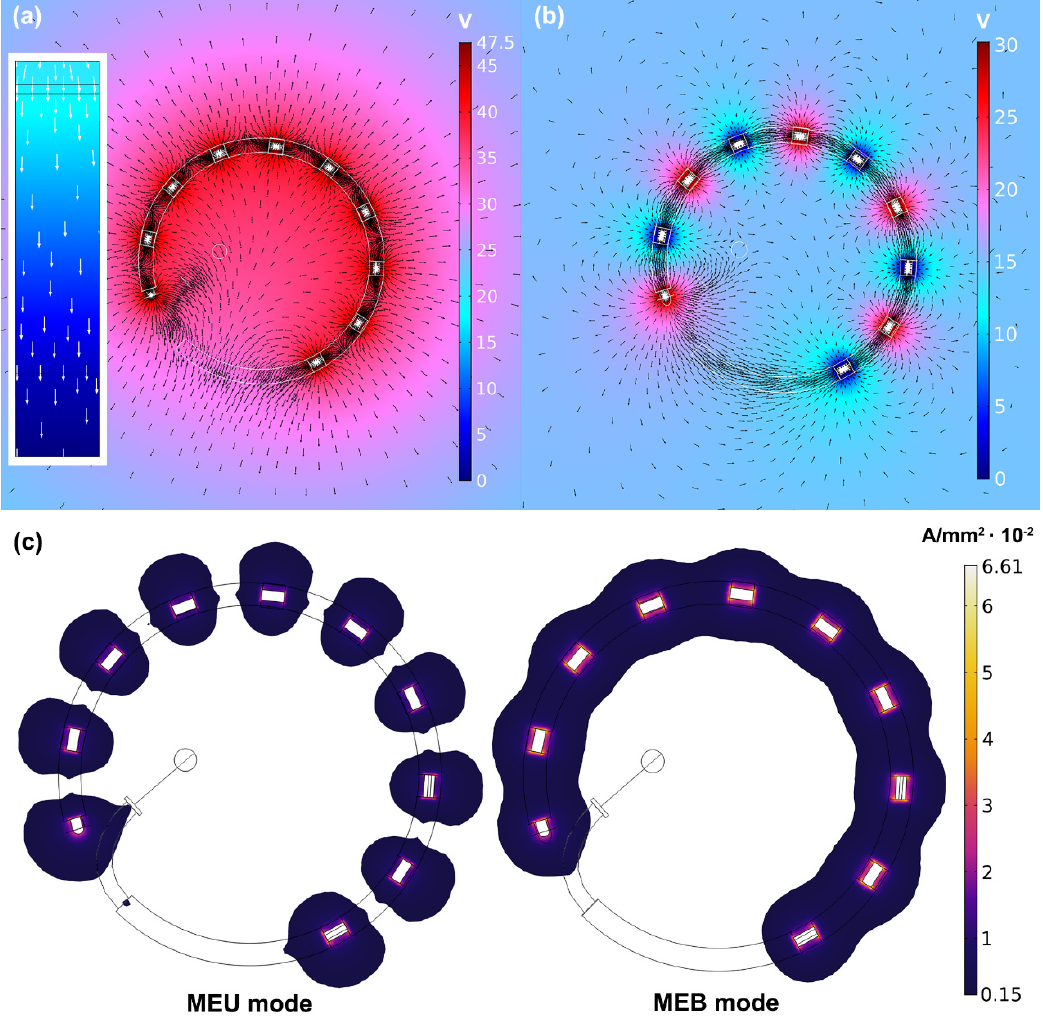
Figure 6. Top view of the current flow and voltage distribution in ( a ) the MEU mode with a side view of the entire model and ( b ) the MEB mode. ( c ) Distribution of current density on the surface of the myocardium at 60 s of RFCA.